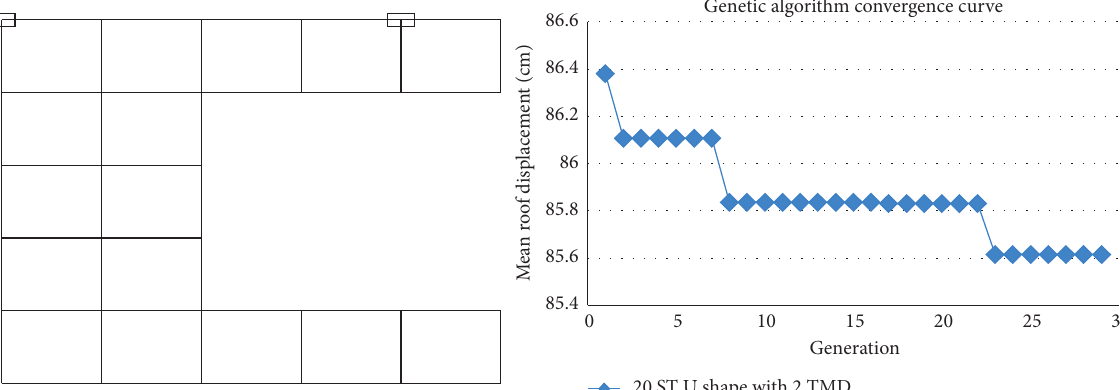
Figure 31: Convergence diagram of the twenty-story irregular U-shaped model with 2 dampers in genetic algorithm (right) and damper optimal positions (left).